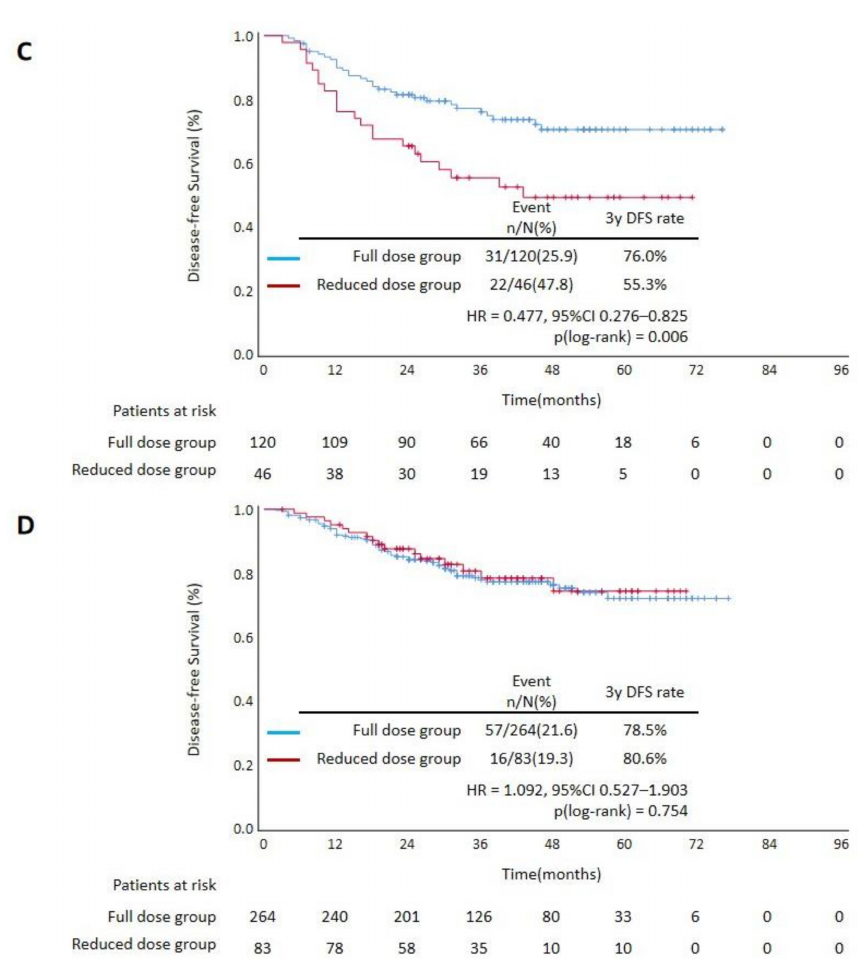
Figure 3. Kaplan-Meier curves of DFS stratified by adjuvant chemotherapy in high-risk stage II and stage III patients: ( A ) high CUL9 expression group vs. low expression group; ( B ) full dose group vs. low douse group among all patients; ( C ) full dose group vs. low dose group among patients with high CUL9 expression; ( D ) full dose group vs. low dose group among patients with low CUL9 expression. HR, hazard ratio; CI, confidence